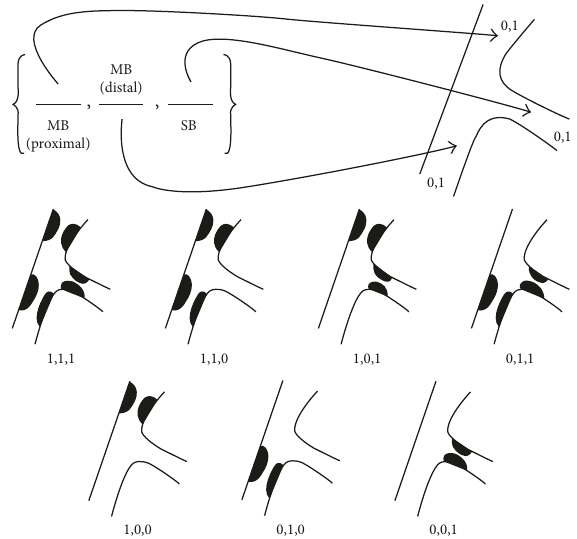
Figure 6: The Medina classification of coronary bifurcation lesions